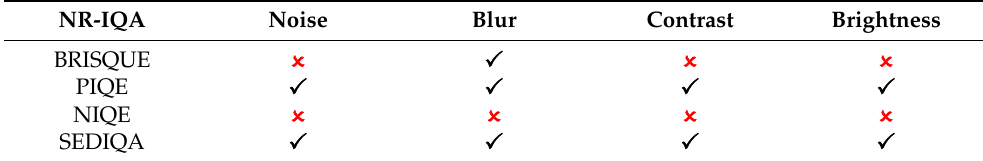
Table 1. NR-IQAs and their ability to respond to image degradations in text-based images.